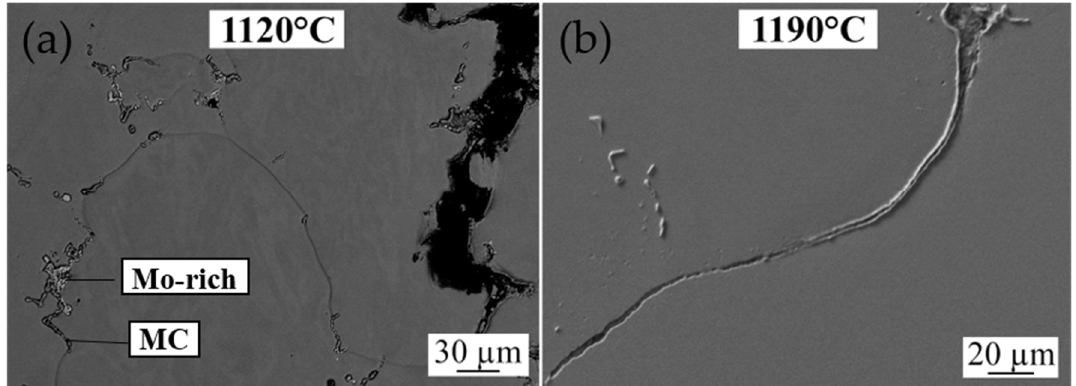
Figure 11. SEM images showing extent of liquation at ( a ) 1120 °C/4 h and ( b ) 1120 °C/4 h after Gleeble testing at 1200 °C.